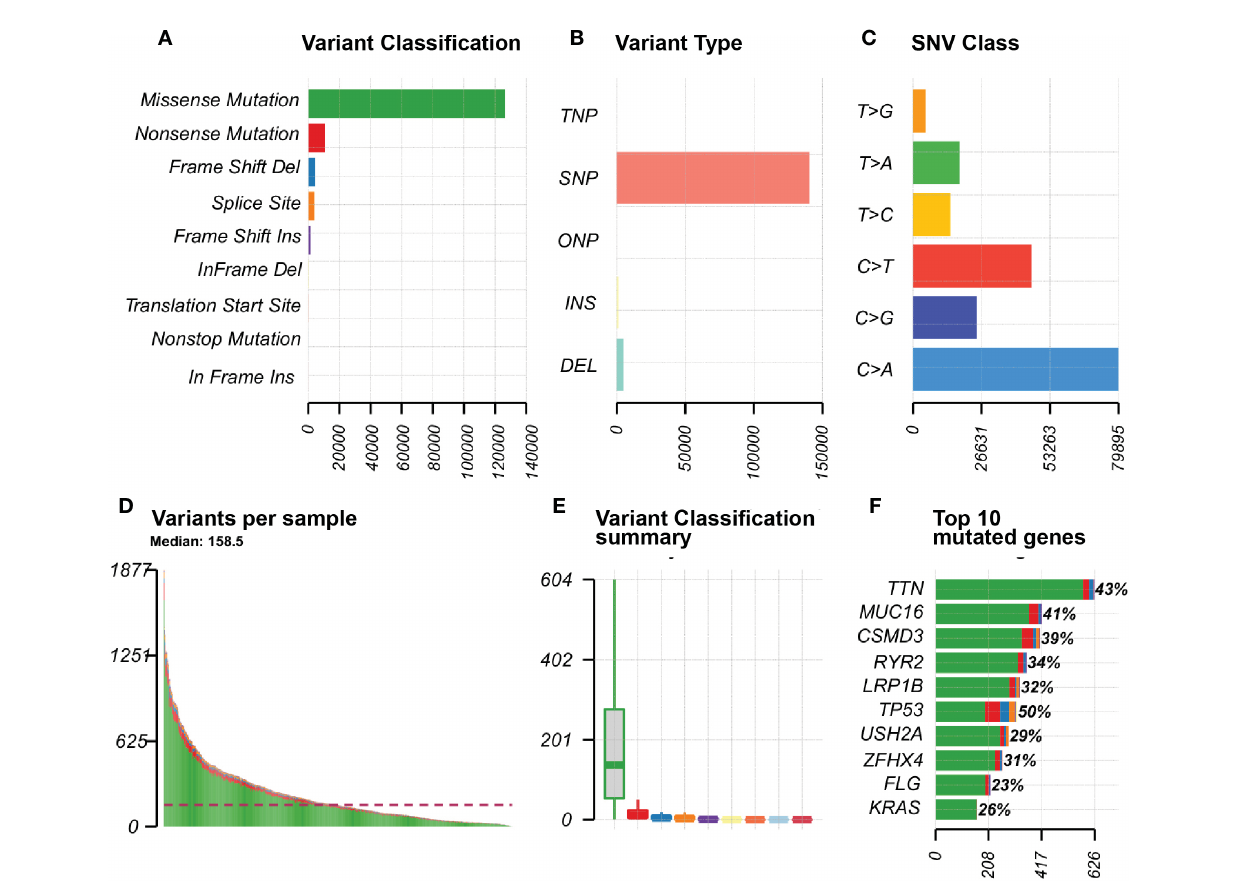
FIGURE 1 Mutation information in LUAD samples SNP, single nucleotide polymorphism; SNV, single nucleotide variant. (A) Variant Classi fi cation of genes in the sample; (B) Variant Type of the gene in the sample; (C) SNV Class of the gene in the sample; (D) Graph of variants for each sample; (E) Summary chart of variant classi fi cation; (F) Top 10 mutated genes in the